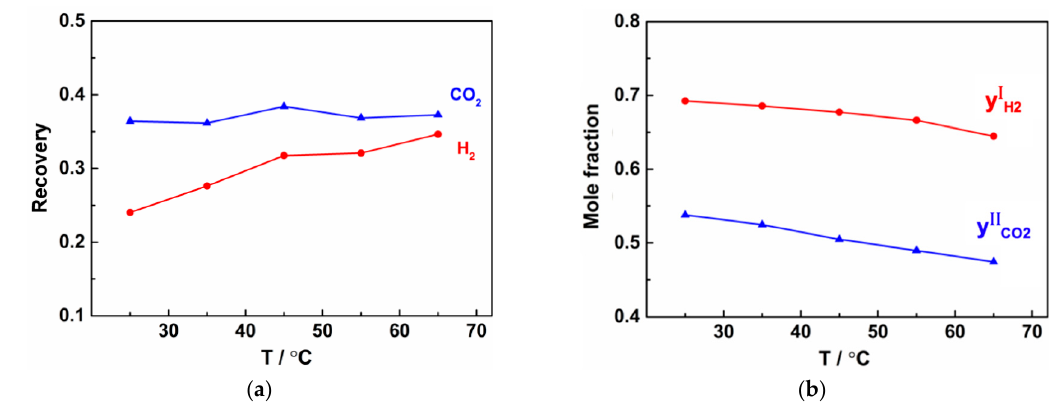
Figure 6. Effects of operating temperature on the purity and recovery of dual membrane separator. ( a ) The recovery of H 2 and CO 2 ; ( b ) the purity of H 2 and CO 2 .